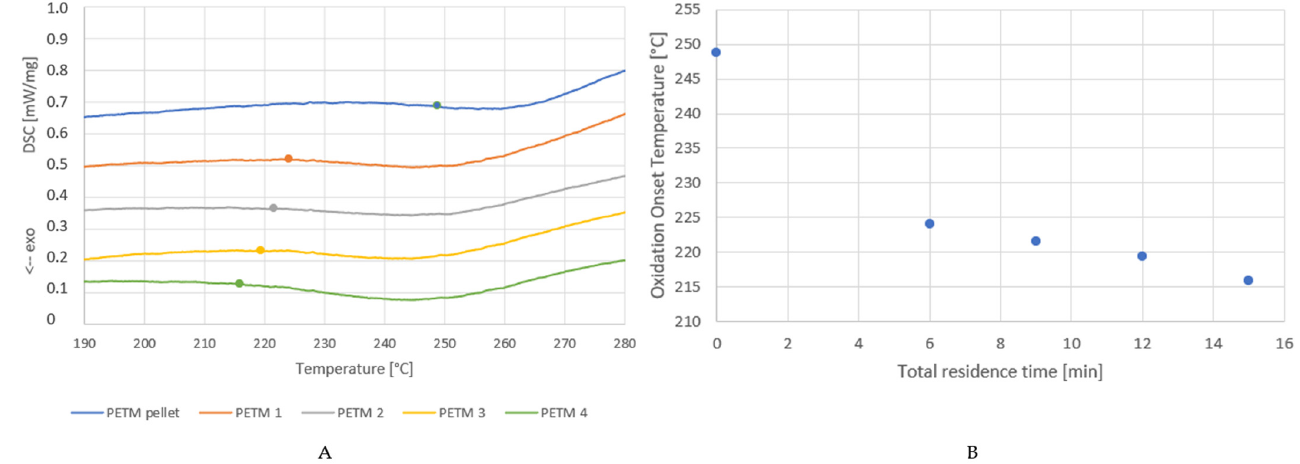
Figure 5. ( A ) DSC signal of the STA analysis of the PETM residence time samples (Table 1) for the determination of the oxidation onset temperature (dots). ( B ) Oxidation onset temperature vs. residence time for PETM samples.